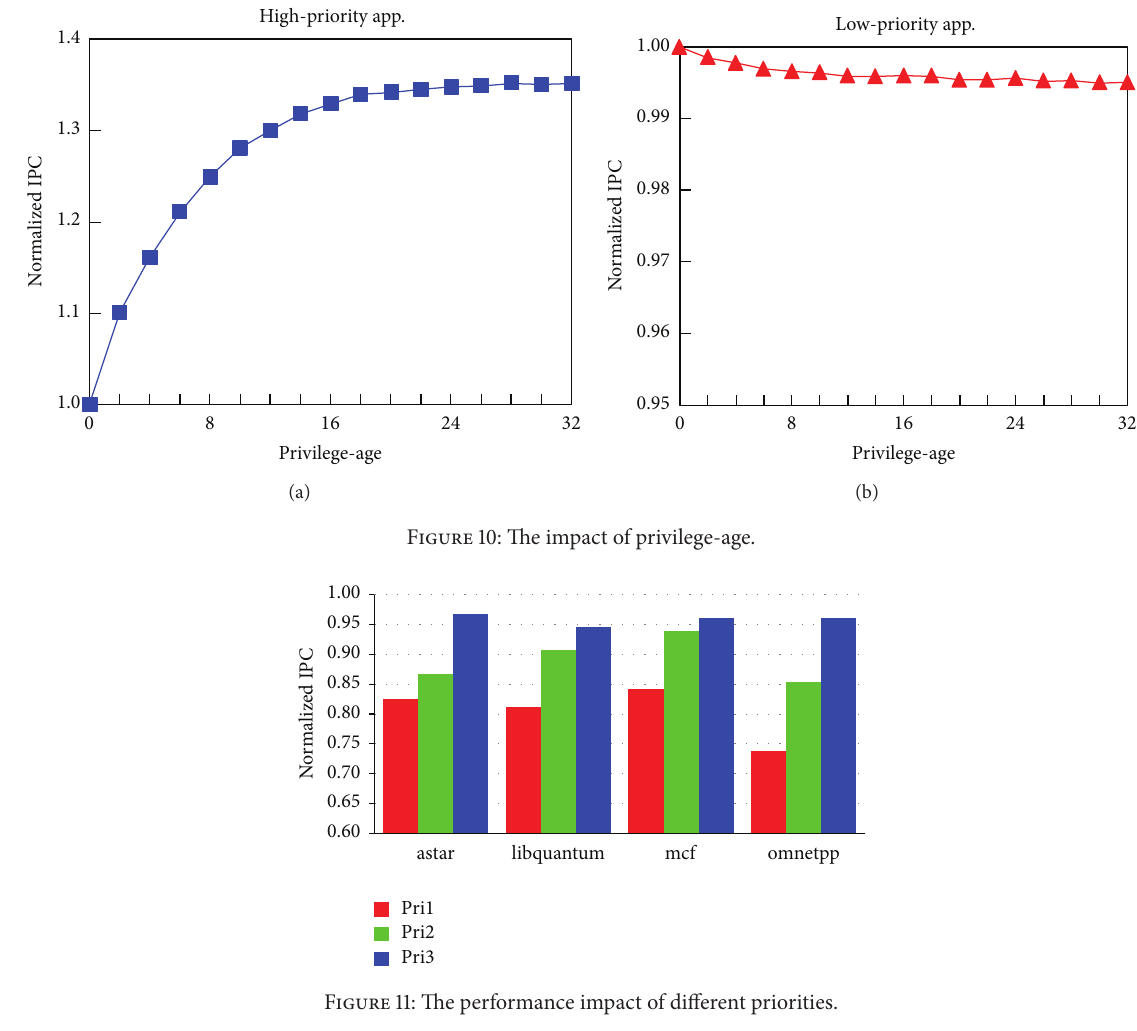
Figure 11: The performance impact of different priorities.